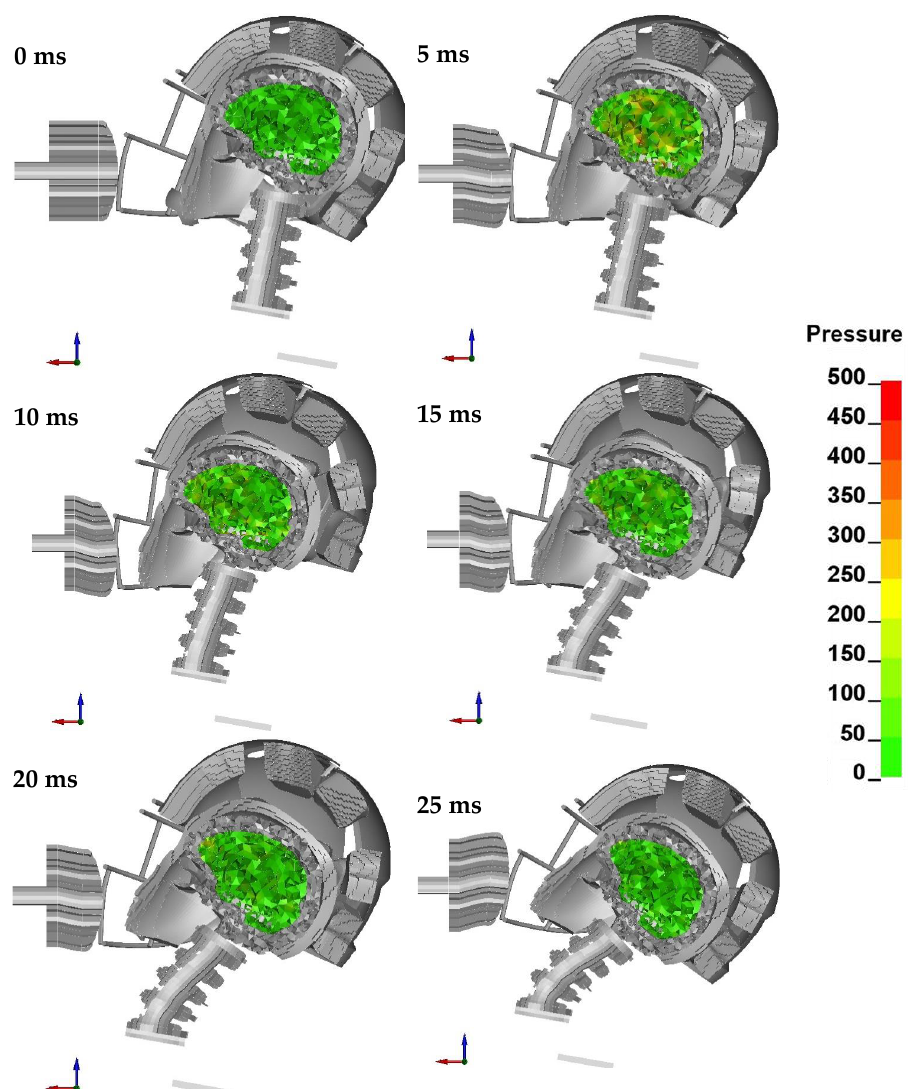
Figure A3. Head kinematics during the numerical test, configuration AP, with the cross-section in the sagittal plane and showing the hydrostatic pressure (kPa) in the brain.